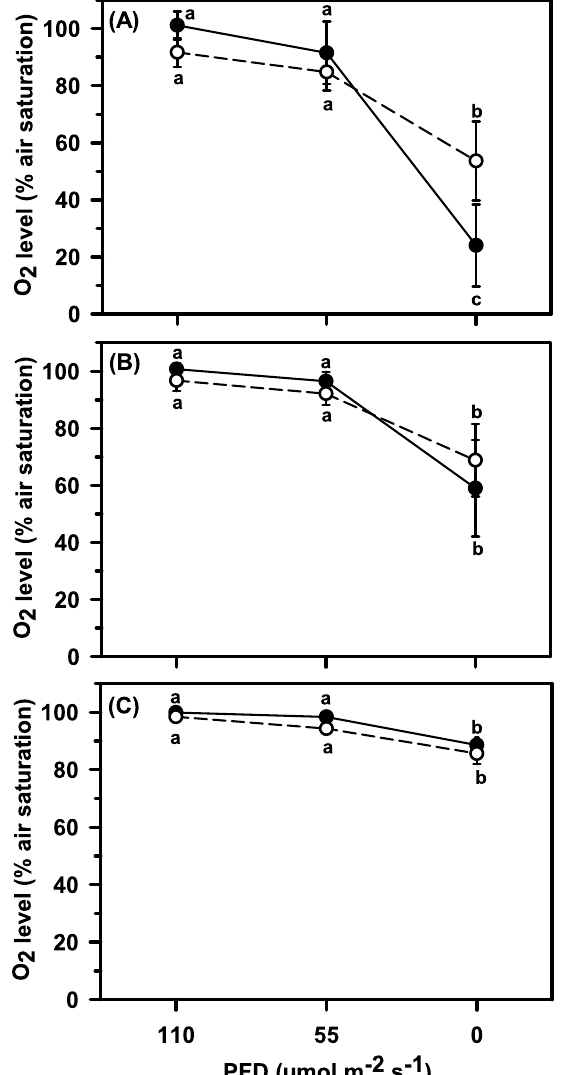
Figure 1. Oxygen levels (% air saturation) measured at a distance of ( A ) 0.2 cm, ( B ) 1.2 cm and ( C ) 2.2 cm above the surface of E. quadricolor , either in the absence of A. frenatus (closed symbol and solid line) or with A. frenatus present (open symbol and dashed line), at 3 different light intensity levels (PFD = 0, 55 and 110 µ mol m − 2 s − 1 ). Data are average values ± 95% CI. Dissimilar letters indicate a significant difference (P < 0.05). N = 8 anemone and 8 clownfish (i.e. 8 separate pairings) using a repeated measures approach across the 3 distances and 3 light intensity